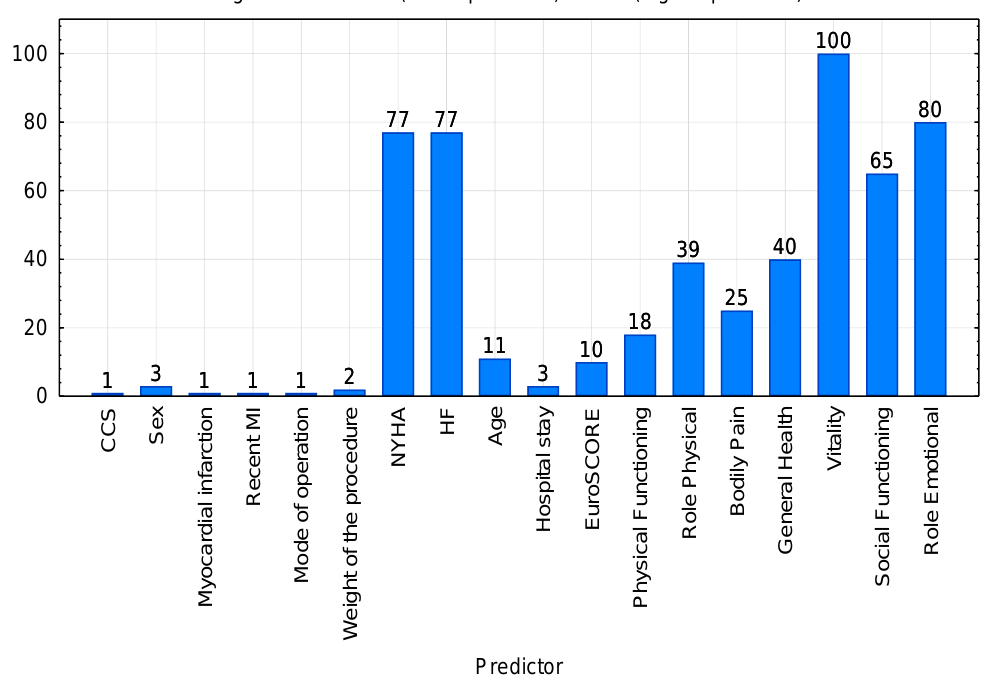
Figure 1. Results of features selection depending on discriminant power. CCS: Canadian Cardiovascular Society classification; NYHA: New York Heart Association classification of heart failure; HF: heart failure; EUROscore: European system for cardiac operative risk evaluation.